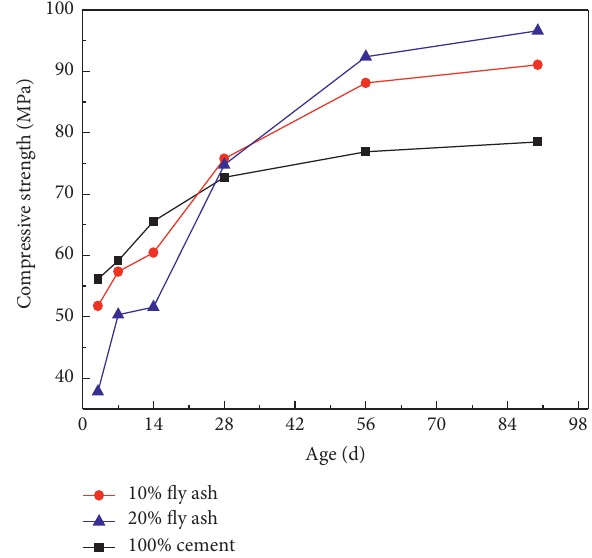
Figure 12: Effect of PCE-2 and fly ash dosage on compressive strength of cement mortar.